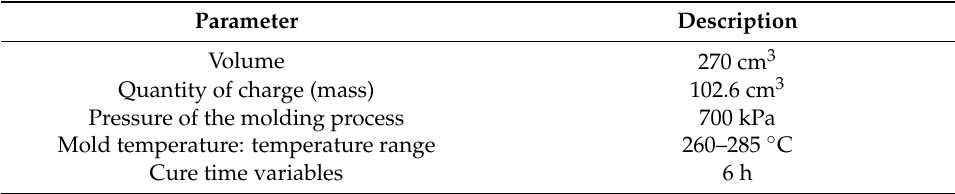
Table 4. Compression molding process parameters.